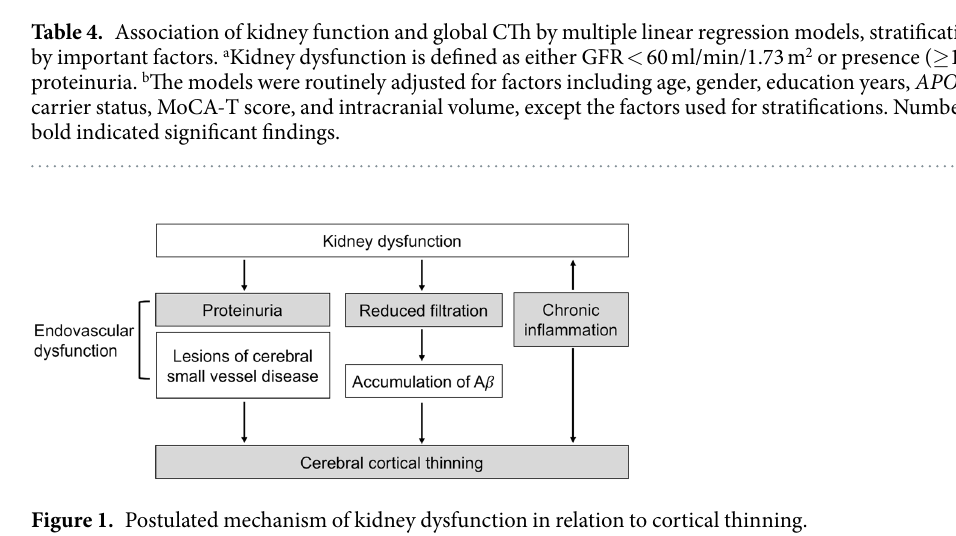
Figure 1. Postulated mechanism of kidney dysfunction in relation to cortical